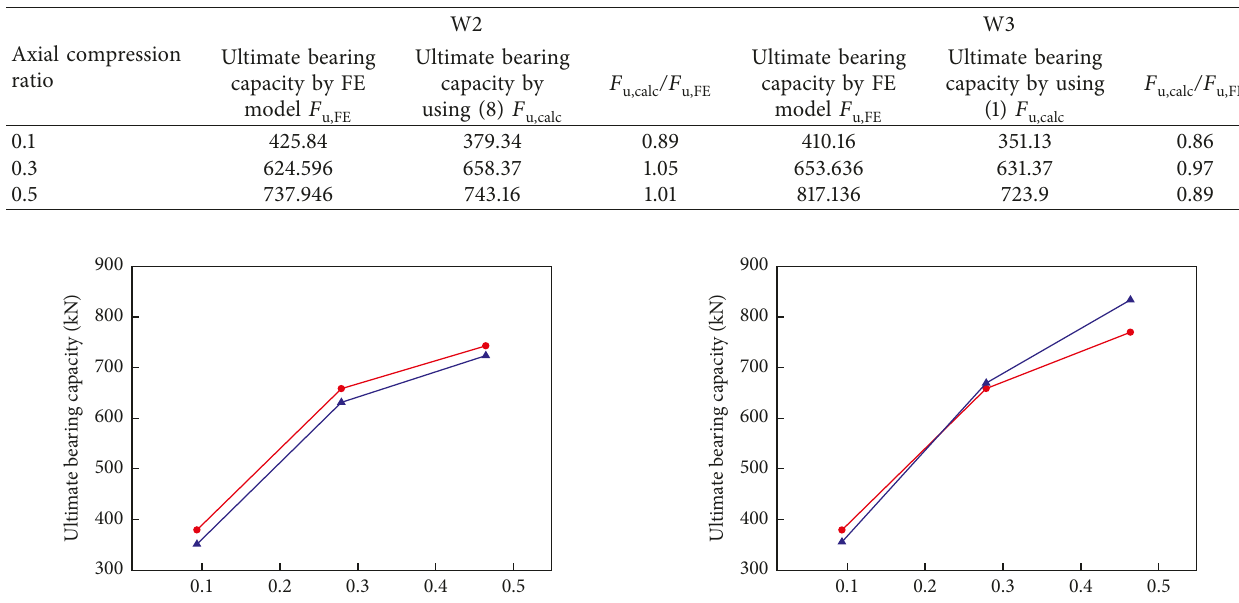
Table 7: Comparison of the ultimate bearing capacity between calculations and simulations.